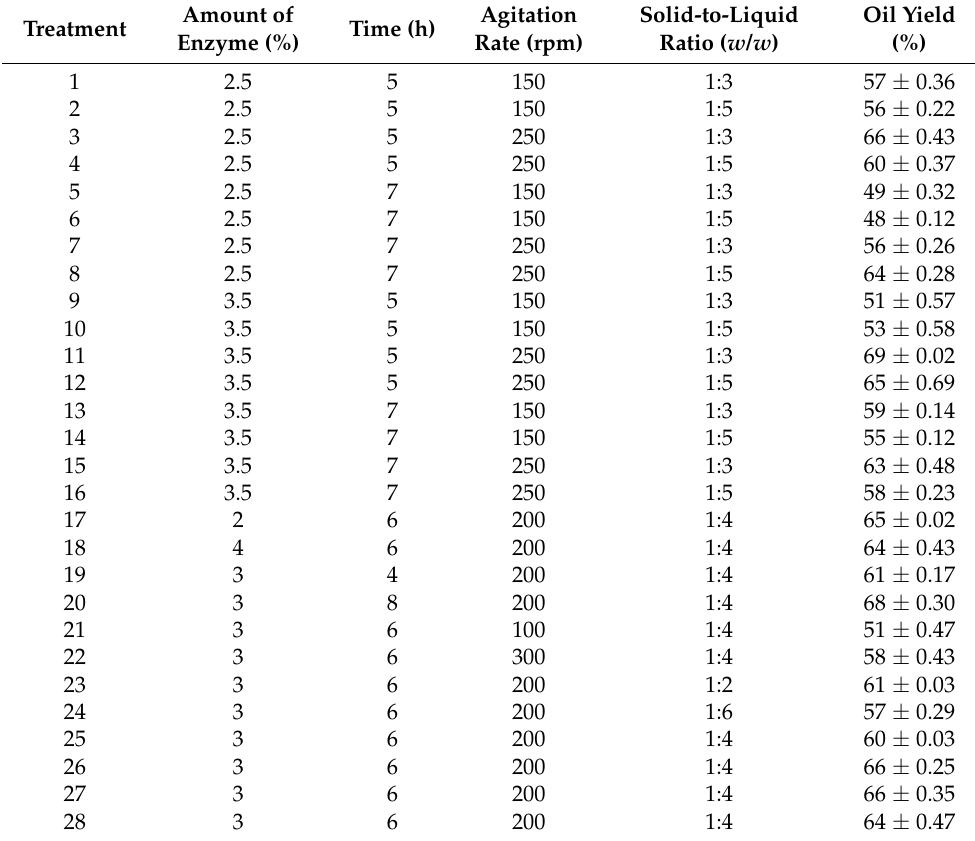
Table 1. Central composite design experiments matrix and the results of the OMSS yield for AEE (with respect to the total oil content present in the mamey seed measured by solvent extraction).